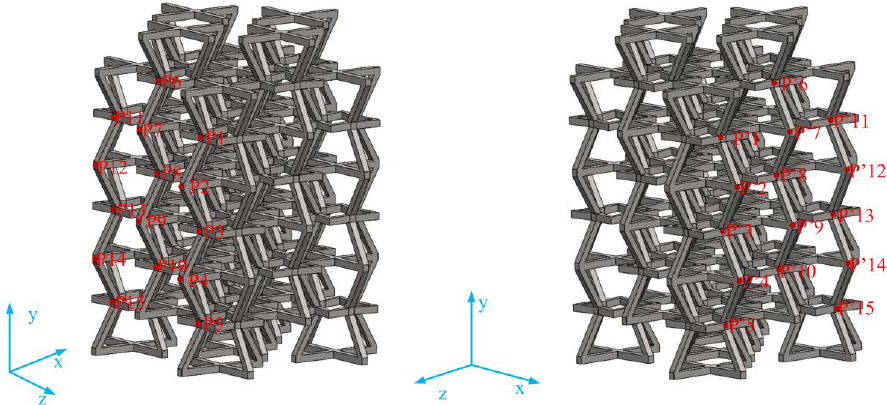
Figure 17. Schematic diagram of the lateral strain points of the simulated structure negative-Poisson-specific space.